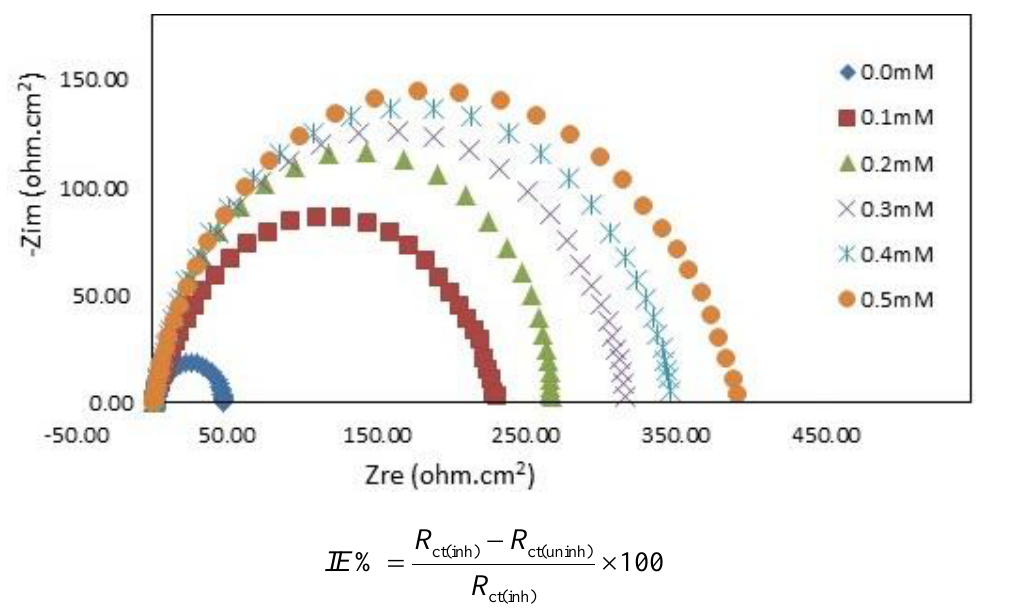
Figure 5. Nyquist plot for mild steel in 1.0 M HCl at 30 °C containing various concentration of